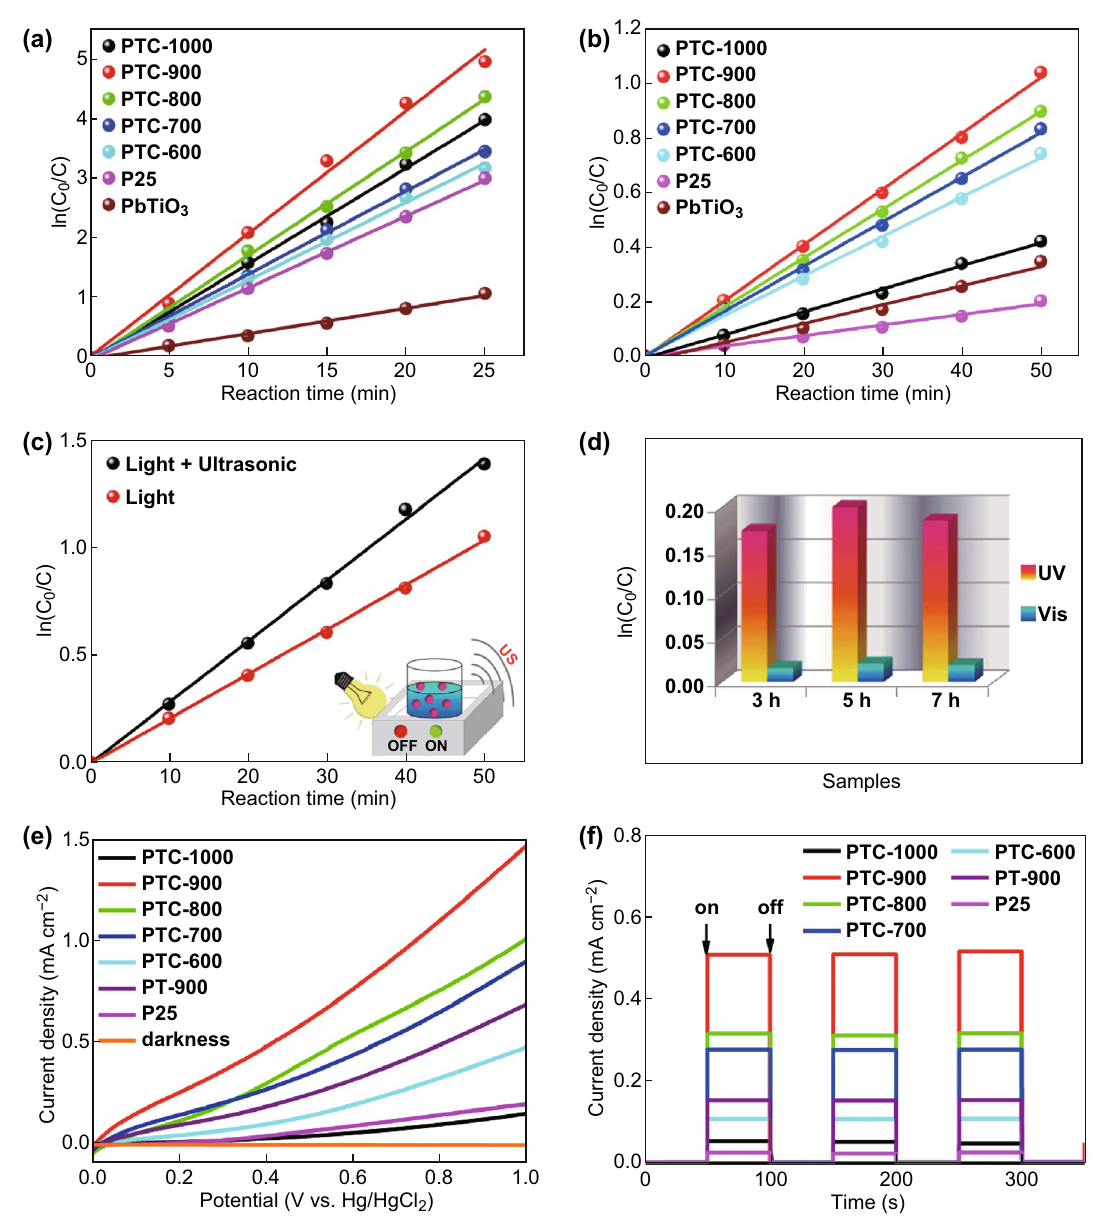
Fig. 5 Photocatalytic MB degradation activity of PTC composites annealed at different temperatures under a UV, b visible, and c ultrasonic- assisted visible light irradiation. d Photocatalytic reactivity of PTC samples annealed at 900 °C for different annealing durations. e Photocurrent density against potential curves of PTC samples annealed at different temperatures. f Photocurrent response of PTC samples and P25 during repeated